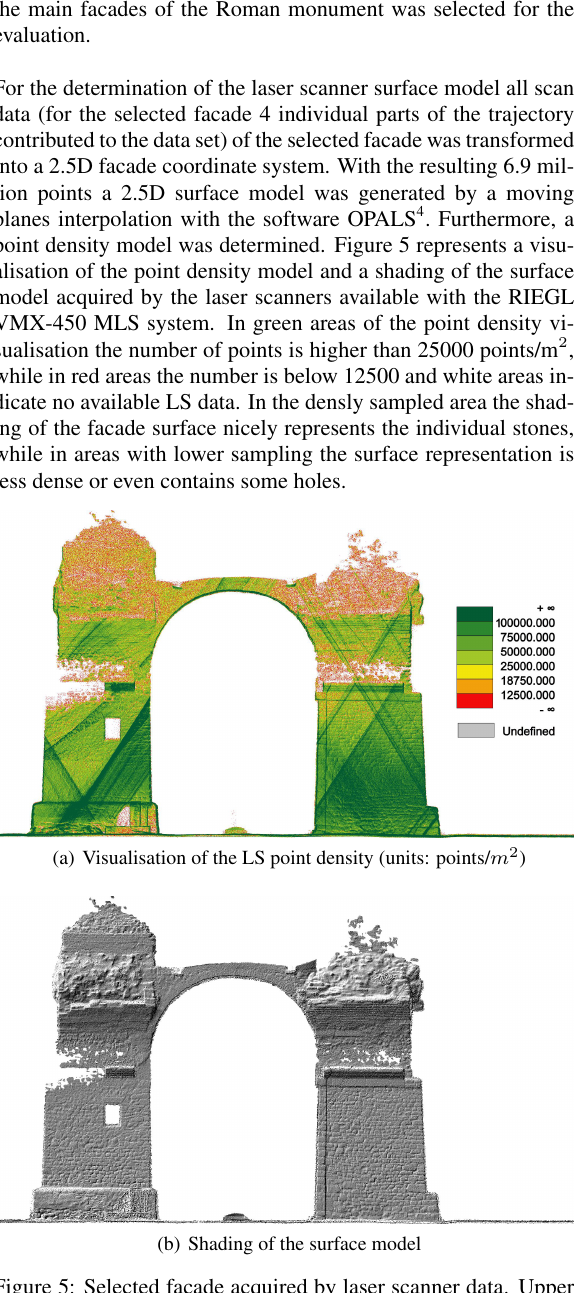
Figure 5: Selected facade acquired by laser scanner data. Upper image: Visualisation of the point density model; Lower image: shading of the resulting 2.5D surface